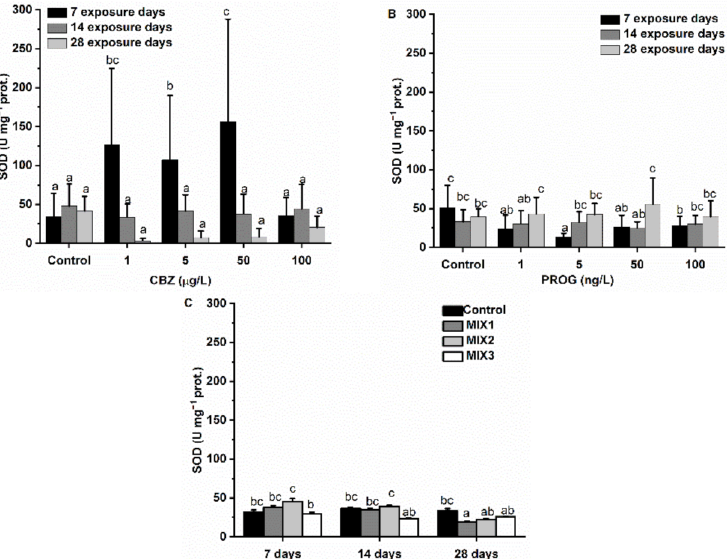
Figure 7. Changes in SOD activity in the liver of Danio rerio exposed to ( A ) CBZ, ( B ) P4, and ( C ) binary mixtures of CBZ and P4 for 7, 14, and 28 days. Data are expressed as mean ± standard deviation of fifteen replicates ( n = 15). Different letters show significant differences at p < 0.05 after a two-way ANOVA followed by Tukey’s post hoc